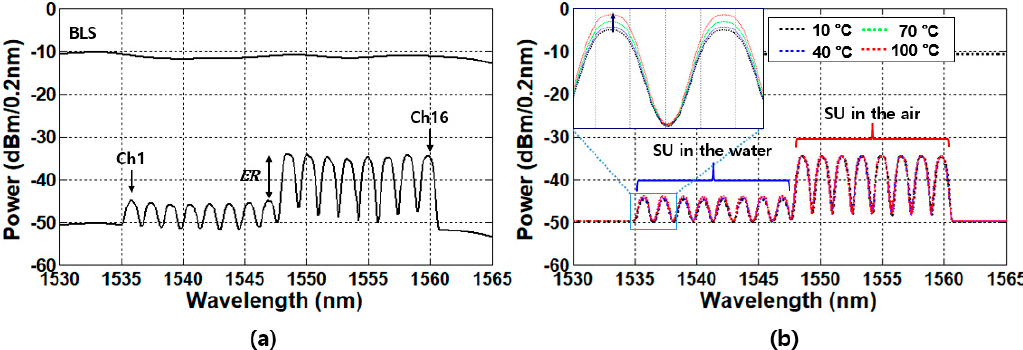
Figure 5. The spectra of half-full (1/2) water level in the back-to-back condition ( a ) measurement result and ( b ) simulation result with temperature variation in the pool.